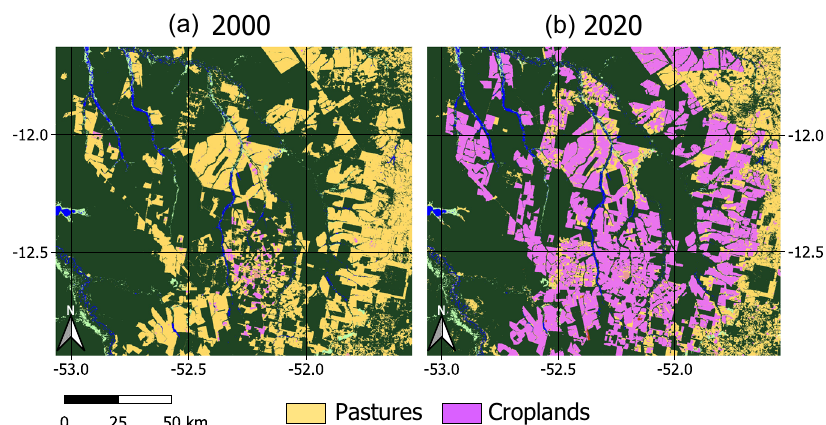
Fig. 1 Cropland expansion from the year 2000 to 2020 in Southern Amazonia. a Land use in 2000. b Land use in 2020. Source: Mapbiomas 19 .